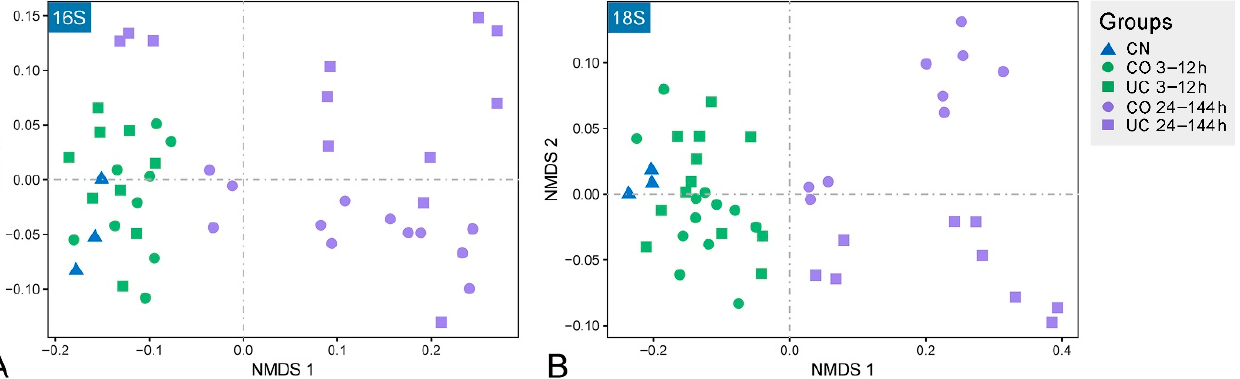
bold. CN: control group, CO: with lid closed, UC: without lid.